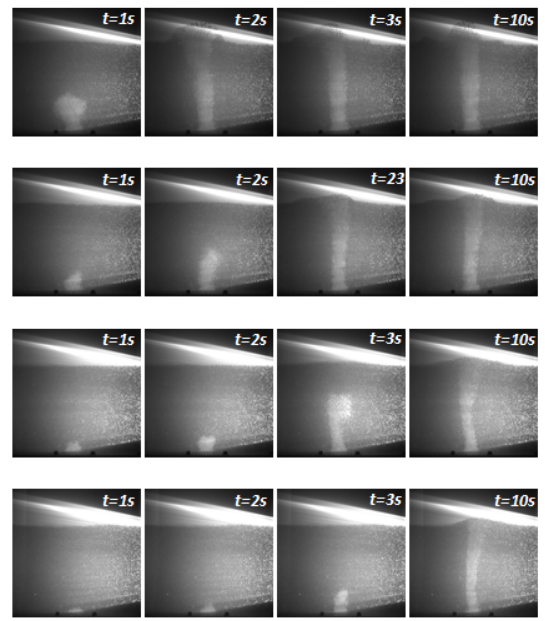
Figure 1. Experimental device (1: Gear pump; 2: Injection port; 3: Metallic mesh plate; 4. Planar lasers; 5: Over-flow set-up; 6: Reservoir) and typical picture of the granular bed obtained by coupling RIM and PLIF techniques.